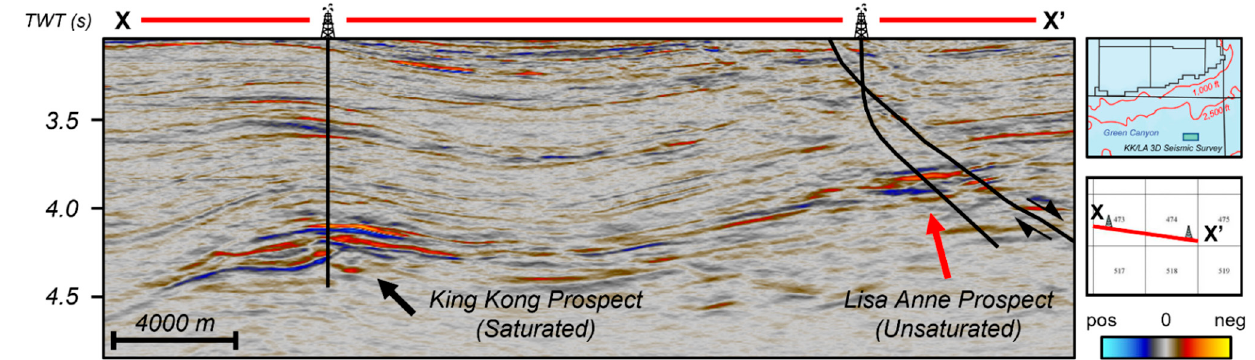
Figure 3. Inline 2391 taken through the KK/LA 3D seismic survey across the King Kong and Lisa Anne wells over Green Canyon Block 473 and 474, offshore Gulf of Mexico (modified from O’Brien [3]).